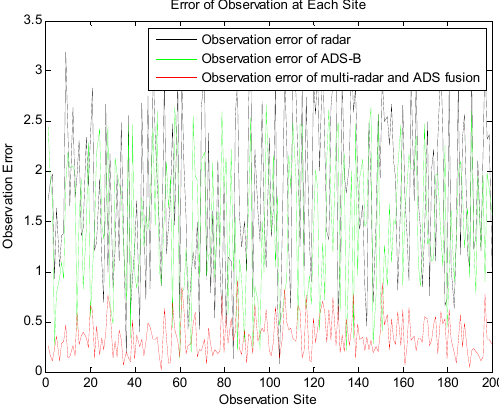
Figure 9. Comparison of the error of observation at each site.